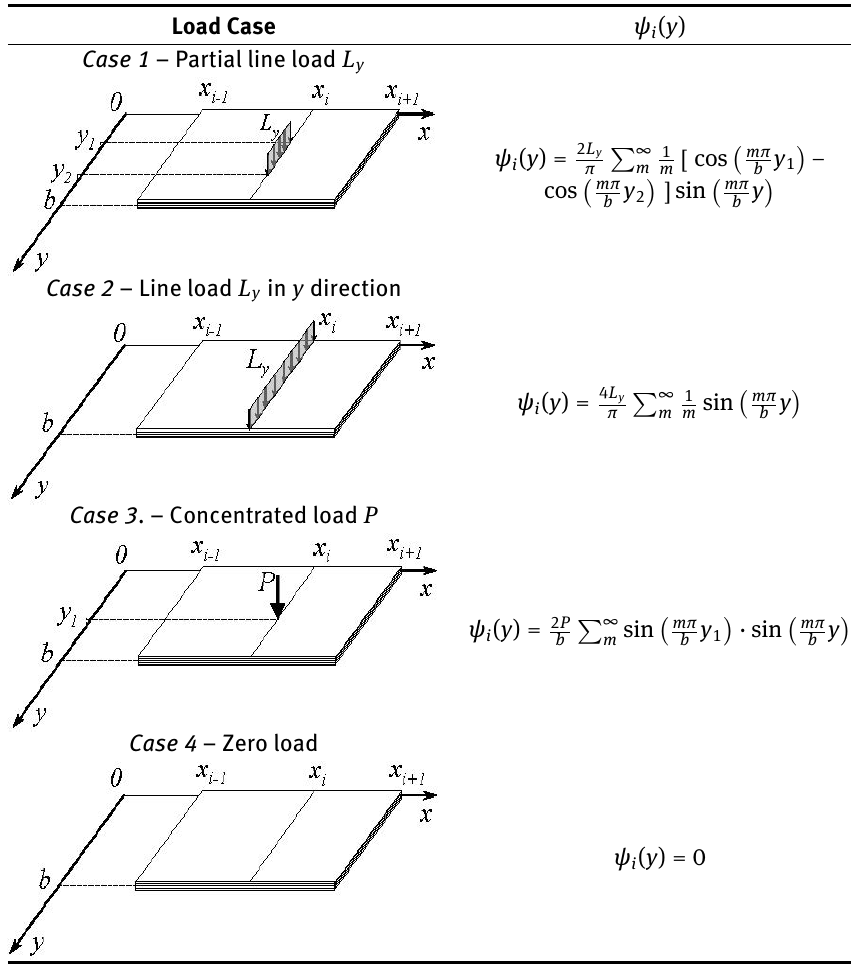
Table 2: Edge loading function ψ i ( y ) along the edge x = x i